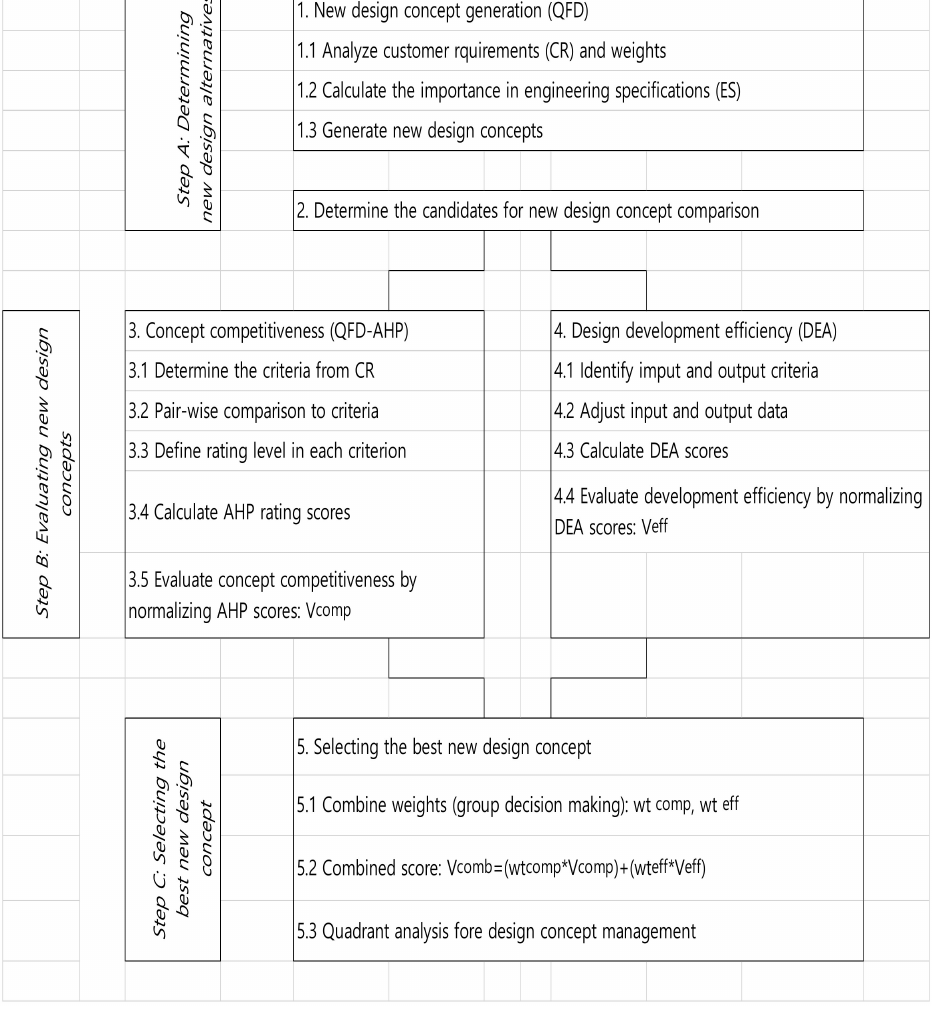
Figure 1. Framework of the proposed method. Source: made by